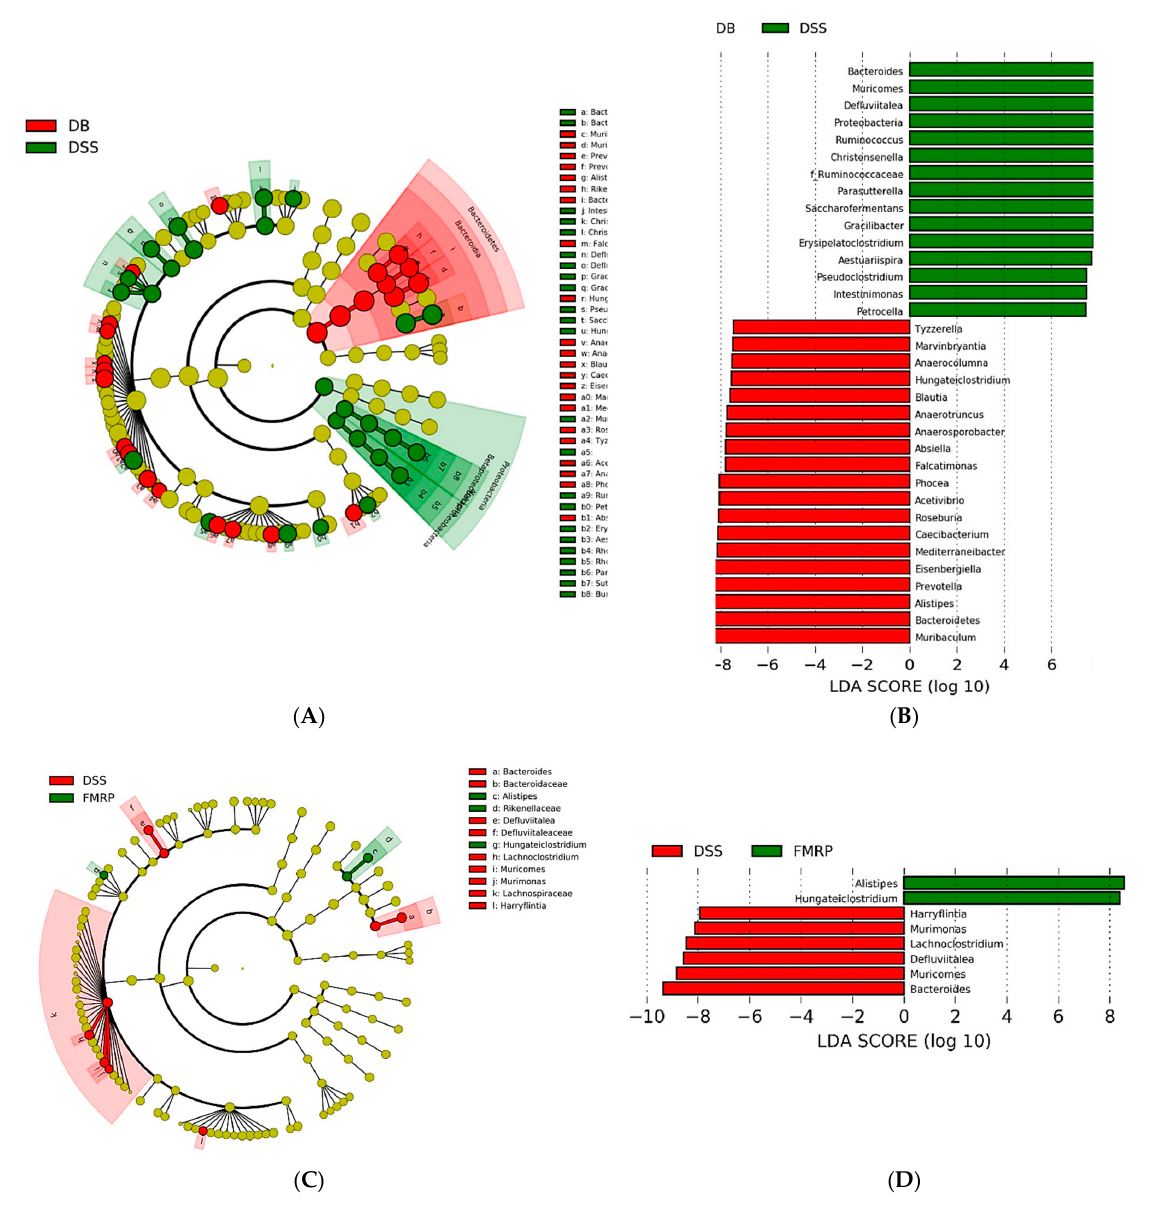
Figure 7. Linear discriminant analysis (LDA) effect size (LEfSe) was performed to examine changes in the gut microbiota following type 2 diabetes mellitus (DB), DB with colitis (DSS), and DSS with FMRP treatment (FL and FH). LEfSe cladogram shows the most differentially abundant taxa between the DB and DSS groups ( A ) and the DSS and FMRP groups ( C ). The taxonomic cladogram was obtained from the LEfSe analysis of 16S rRNA sequences. Bars represent the effect size for each taxon between the DB and DSS groups ( B ) and the DSS and FMRP groups ( D ). The length of the bar represents the log10-transformed LDA score. The threshold of the logarithmic LDA score for discriminative features was set to 2.0. The taxon of bacteria at the genus level with statistically significant change ( p < 0.05) in the relative abundance is shown alongside the horizontal lines. Taxa enriched for FMRP are shown in green, and DSS-enriched taxa are shown in